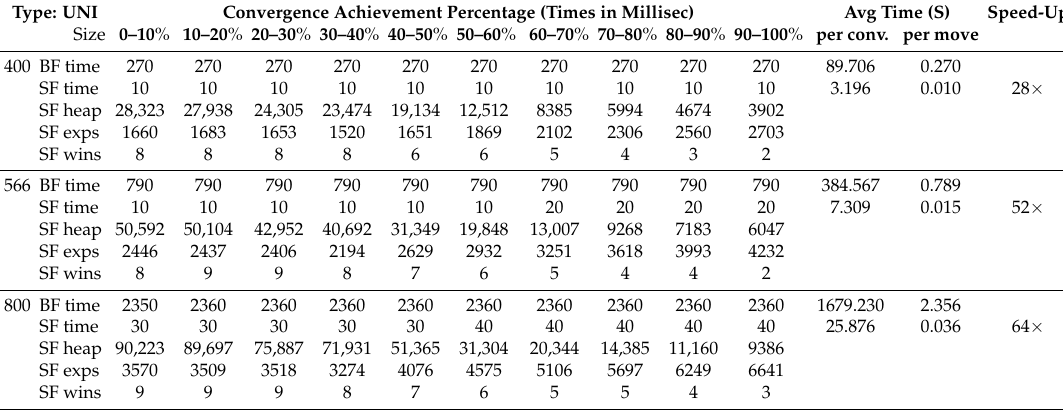
Table 5. Comparing SF and BF in converging to a local optimum starting from a random tour. Type: